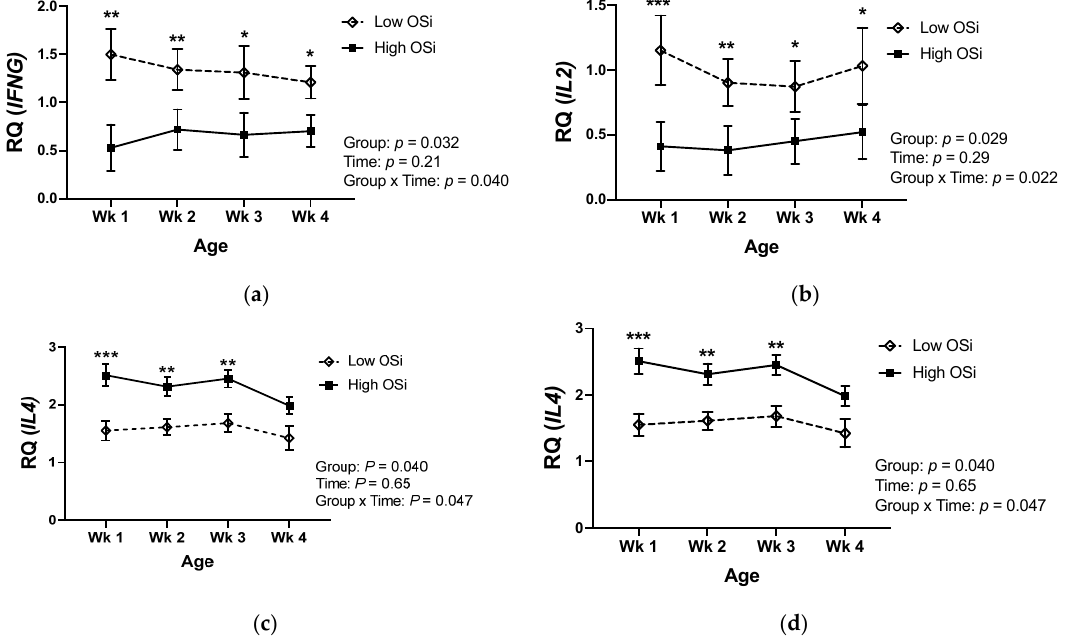
Figure 3. Relative mRNA expression of the genes ( a ) Interferon Gamma ( IFNG ), ( b ) Interleukin 2 ( IL2 ), ( c ) Interleukin 4 ( IL4 ), and ( d ) Interleukin 10 ( IL10 ) in peripheral mononuclear blood cells of newborn calves with contrasting levels of redox balance, as assessed by the oxidant status index (OSi). The “low Osi” group includes the 6 calves with the lowest average OSi values based on weekly measurements. Data were analyzed using mixed models with repeated measures and Tukey’s honestly significant difference test. Results are expressed as estimated means ± SEM of relative quantity (RQ). * p < 0.05, ** p < 0.01, *** p < 0.001.